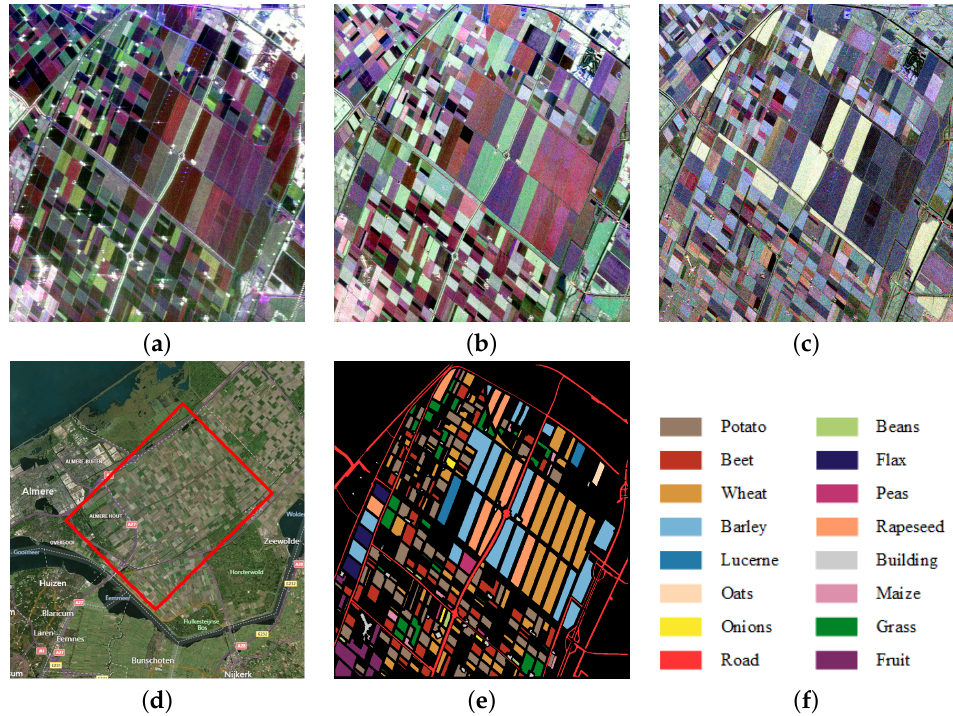
Figure 5. The Flevoland dataset. ( a – c ) The pseudo Pauli images of P-, L-, and C-band, respec- tively. ( d ) The geographic location of the dataset (marked with a red frame), which is centered at ( 52 ◦ 22 (cid:48) 00 (cid:48)(cid:48) N,5 ◦ 23 (cid:48) 16 (cid:48)(cid:48) E ) . ( e ) The ground truth. ( f ) The colormap of the 16